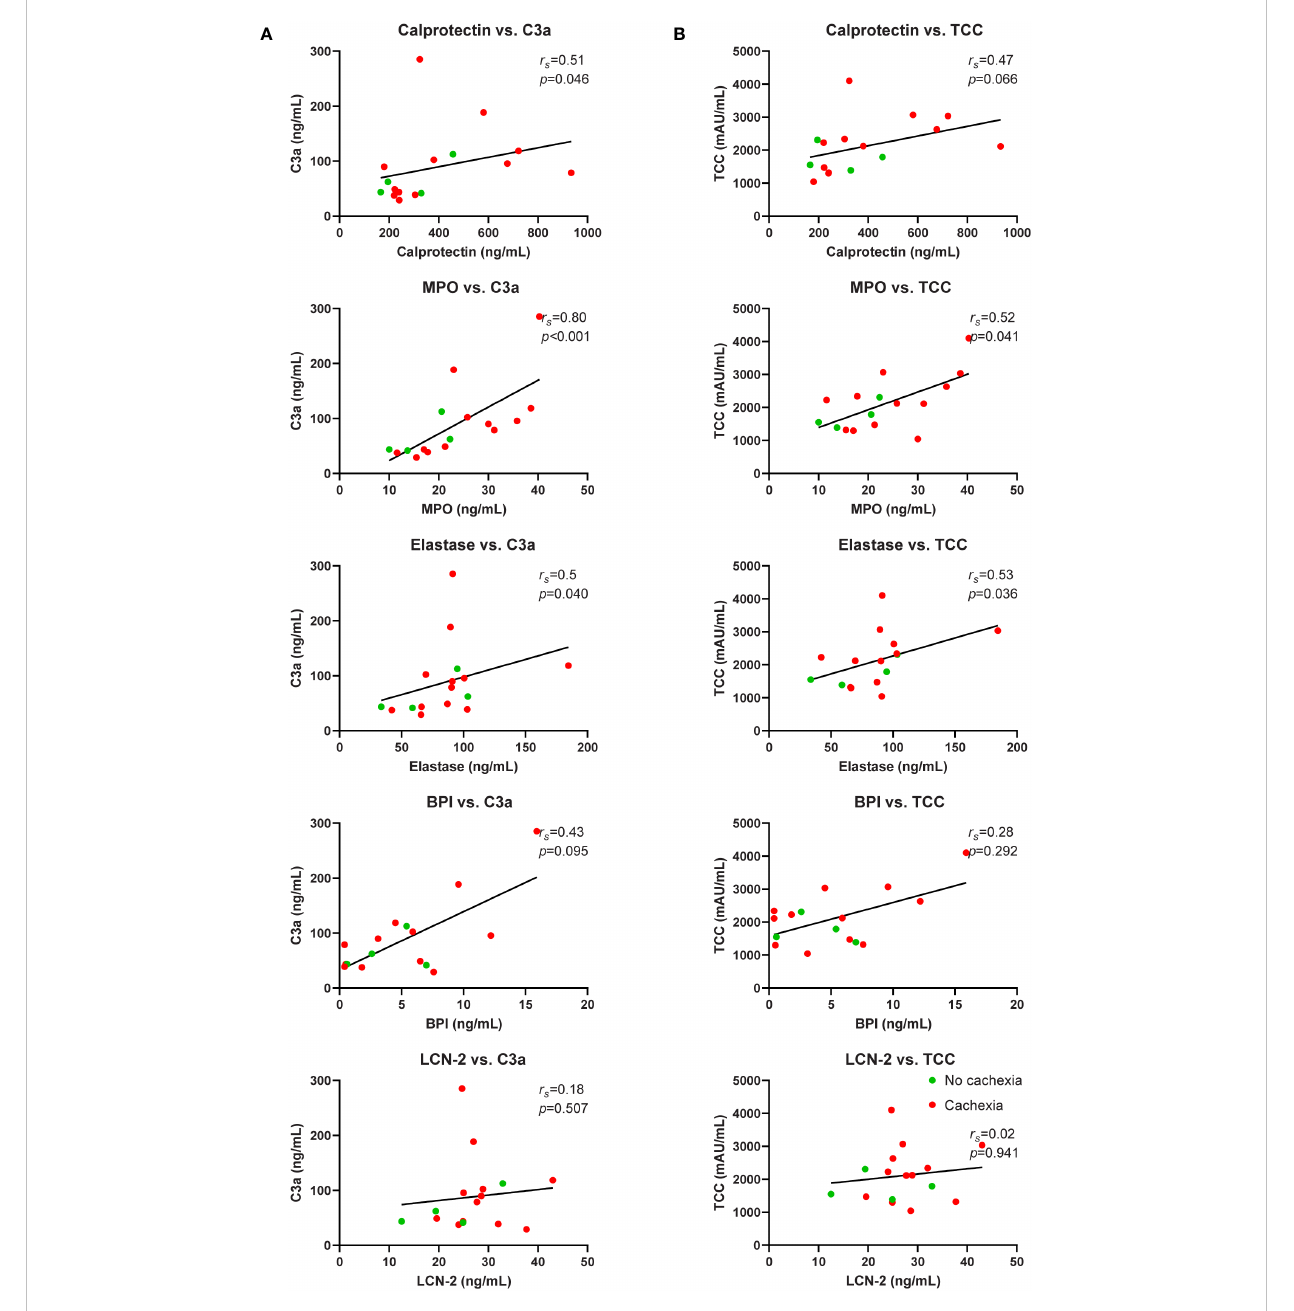
FIGURE 6 Correlation analysis of neutrophil activation markers and complement system activation markers. Relationship between systemic levels of C3a and calprotectin, MPO, elastase, BPI, and LCN-2 (A) . Relationship between systemic levels of TCC and calprotectin, MPO, elastase, BPI, and LCN-2 (B) . n=16 for each graph. Spearman ’ s rank correlation coef fi cient ( r s ) and level of signi fi cance are indicated in the respective